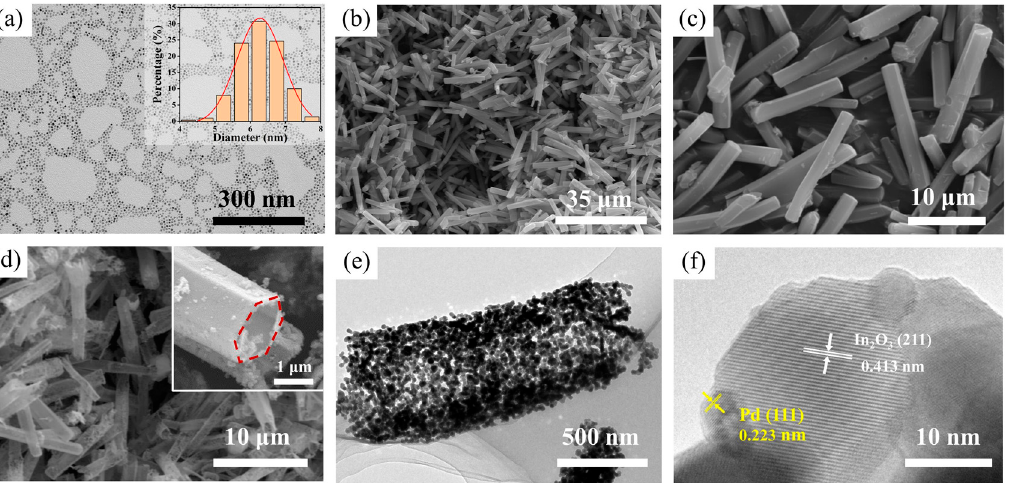
Figure 4. ( a ) TEM images of Pd nanoparticles (the inset is the size distribution histograms); SEM images of ( b , c ) MIL-68 (In) precursors, and ( d ) pristine In 2 O 3 (the inset is the enlargement of the cross section of In 2 O 3 ); ( e , f ) HRTEM images of Pd@In 2 O 3 -2.